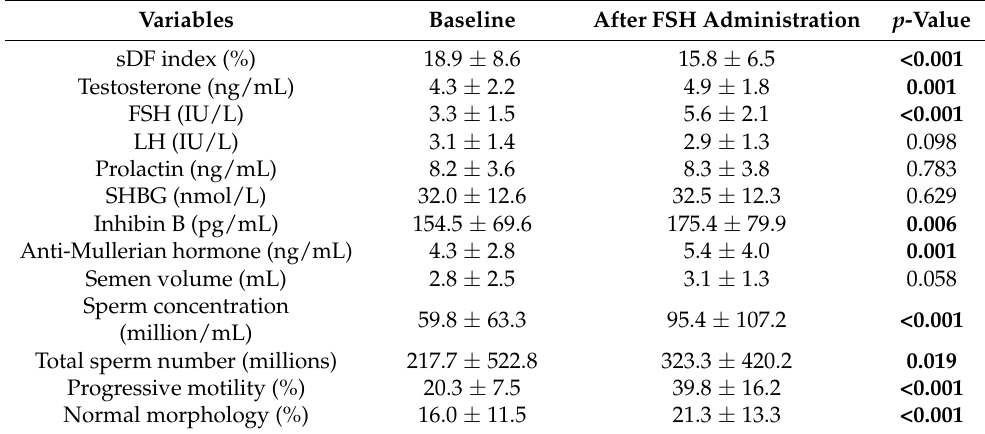
Table 4. Comparison between baseline and after follicle stimulating hormone (FSH) administration, considering both hormone and semen parameters, using Mann–Whitney U -test. Data are expressed as mean ± standard deviation. Bold characters reported statistically significant